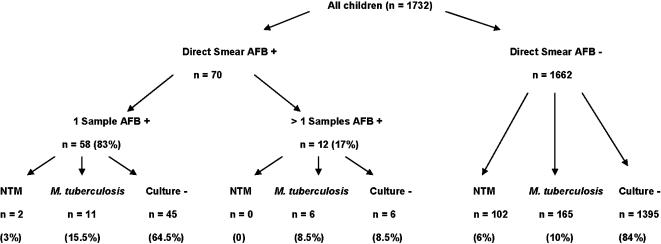
Distribution of children with NTM (n = 104) or M. tuberculosis (n = 182) isolates according to whether acid-fast bacilli (AFB) were detected on initial direct smear microscopy.Children with dual NTM and M. tuberculosis isolates (n = 5) are excluded.Proportions are presented as a percentage of Direct Smear AFB+(n = 70) or Direct Smear AFB–children (n = 1662).Data are n (%).